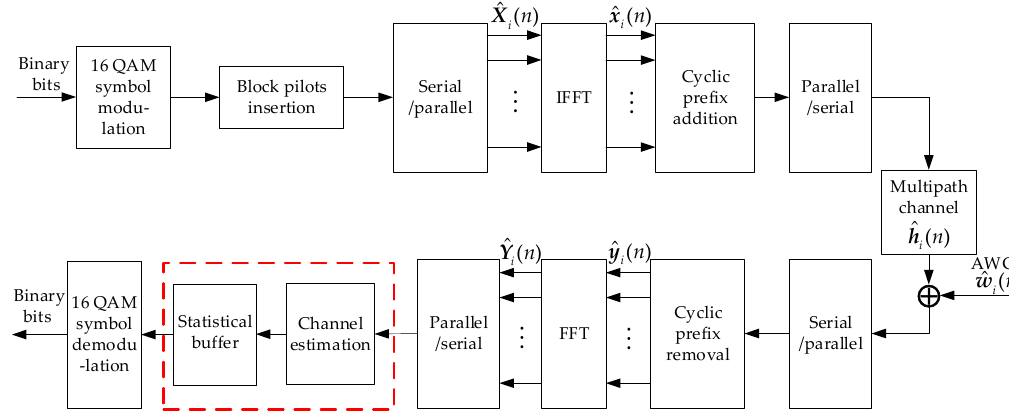
Figure 1. System model of cyclic prefix (CP)-OFDM. OFDM: orthogonal frequency division multiplexing; QAM: quadrature amplitude modulation; IFFT: inverse fast Fourier transform; FFT: fast Fourier transform.